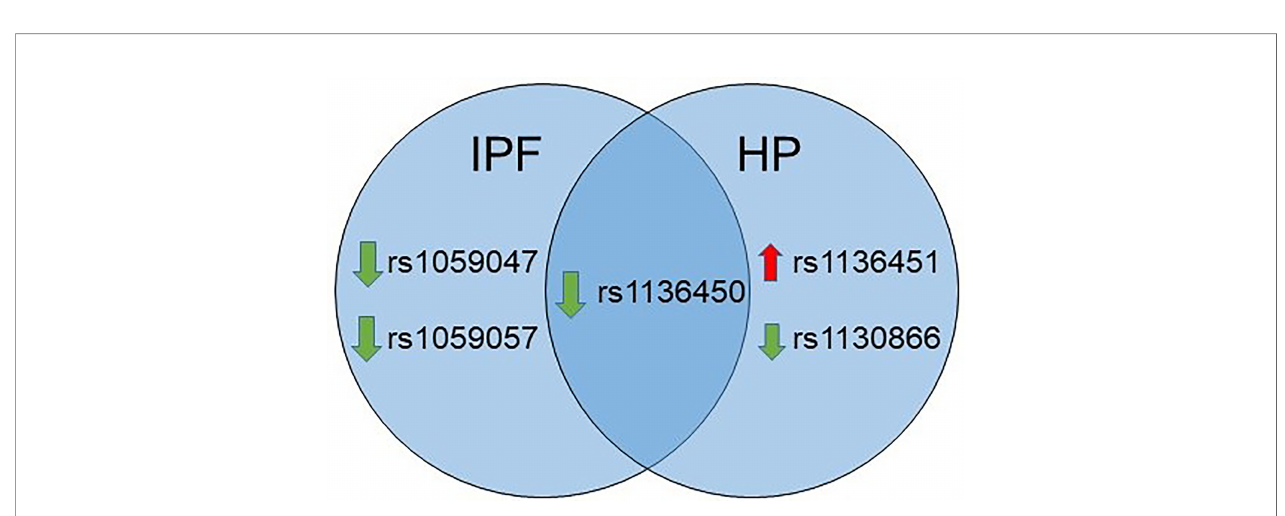
FIGURE 1 | A schematic presentation of the SFTPA1 gene SNPs is shown. The relative location of the gene is shown from centromere (C) to telomere (T). The numbers above the solid black line indicate the amino acid number with the corresponding nucleotide change shown in parenthesis. The SNP id is noted below the black line. The arrow indicates transcriptional orientation. The transmitted haplotypes (TG, GA, and GG) are shown in a two-SNP model and are associated with increased risk of IPF (OR: OR = 2.372, p = 0.004, OR = 2.368, p = 0.004 and OR = 2.265, p = 0.004, respectively). The TG haplotype is constituted by the rs1059047 Val (T) at codon 19 and the rs1136450 Val(G) at codon 50, the GA haplotype by the rs1136450 Val(G) at codon 50 and the rs1136451 Prol(A) at codon 62 and the GG by the rs1136451 Prol(G) at codon 62 and the rs1059057 Thr(G) at codon 133. Of note, the T/C and C/G alleles change the encoded amino acids at codons 19 Val/Ala and 50 Val/Leu, respectively, but the SNPs at codons 62 and 133 do not change the encoding amino acids (19).